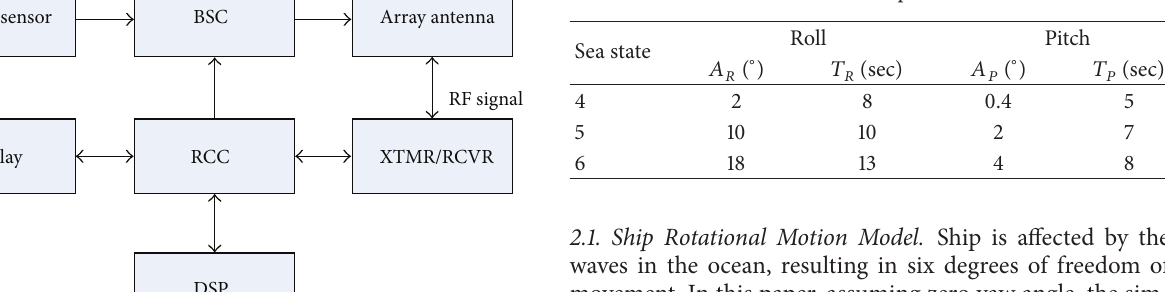
Table 1: Sea state